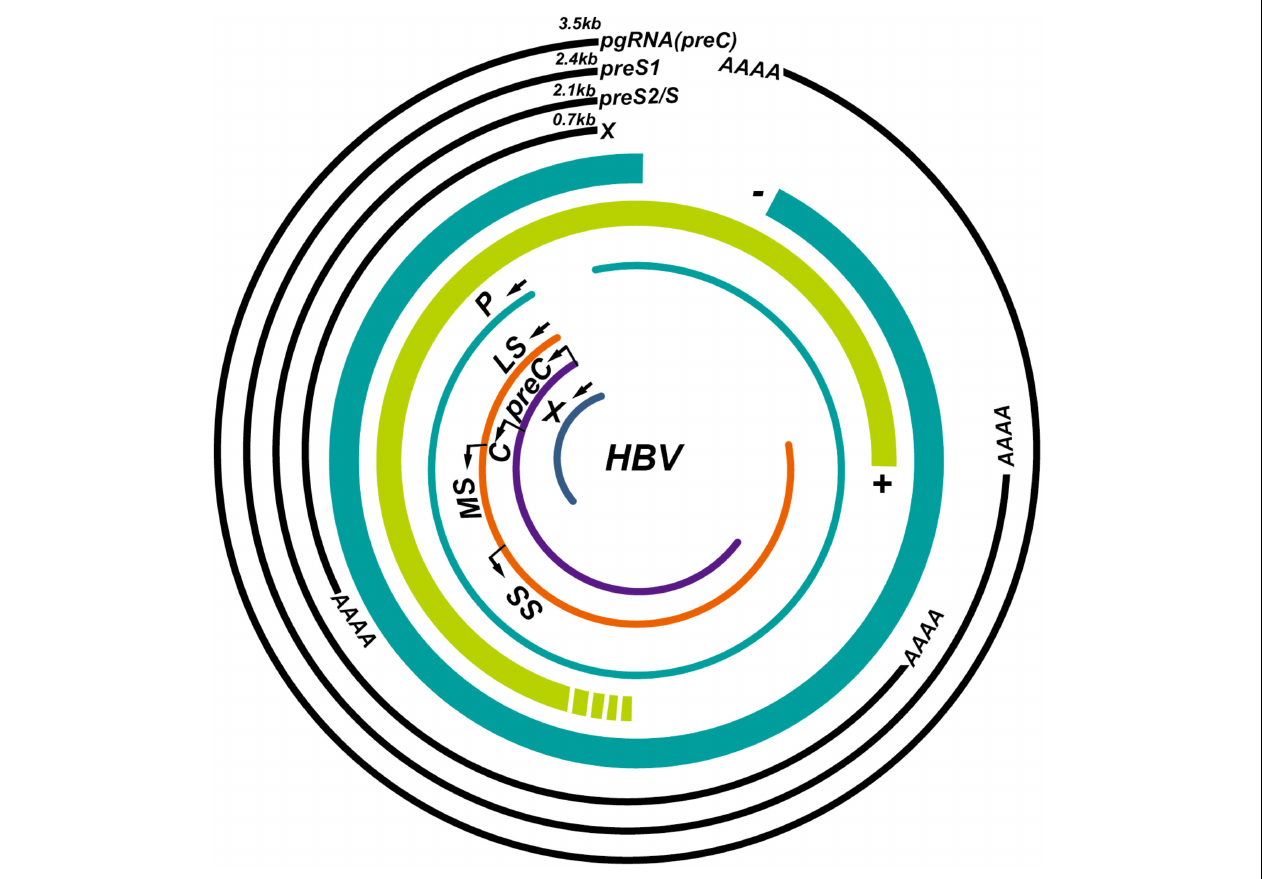
FIGURE 1 | Illustration of the hepatitis B virus (HBV) genome and its overlapping open reading frames and transcripts. HBV is a partially double-stranded DNA virus that transcribes four major transcripts: pgRNA (3.5 kb), preS1 (2.4 kb), preS2/S (2.1 kb), and X (0.7 kb) and synthesizes seven proteins: P, polymerase; LS, large S; MS, middle S; SS, small S; preC, pre-Core; C, core; X,